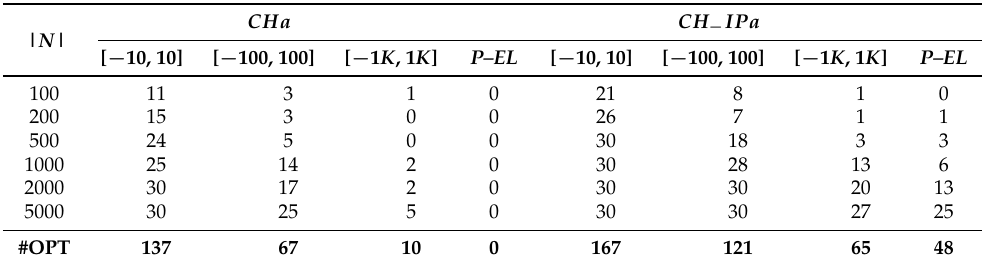
Table 3. Number of optimal solutions identified by CHa and CH − IPa —large